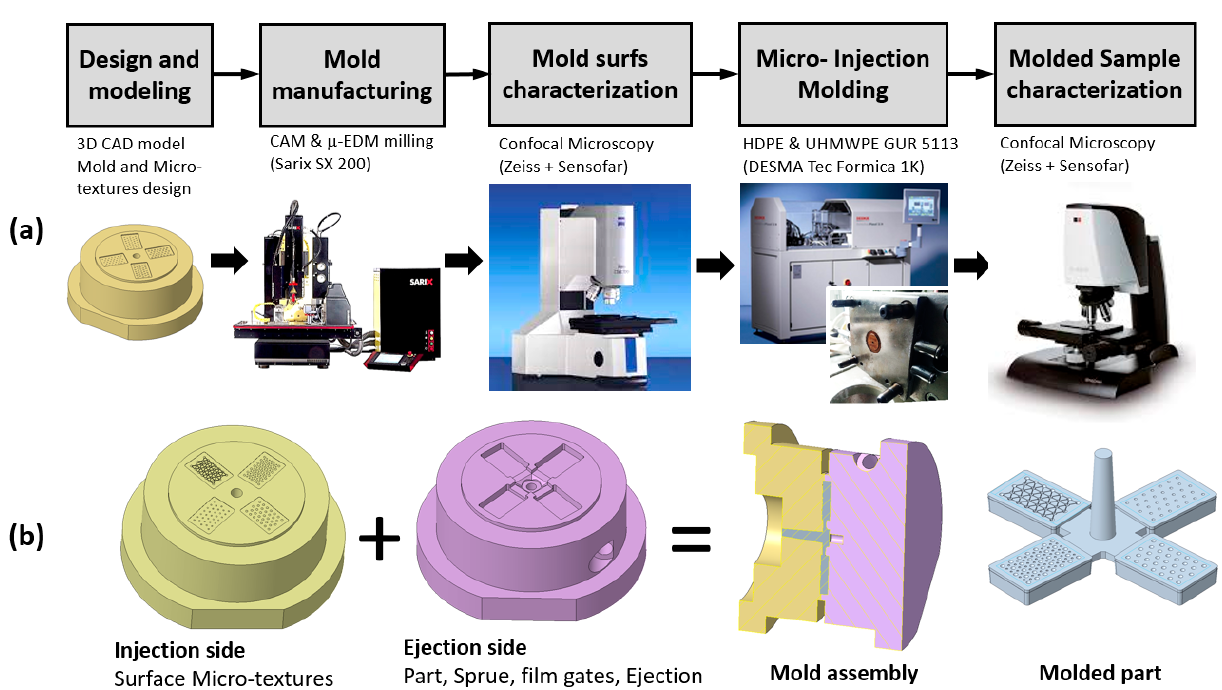
Figure 6. Micro-manufacturing process chain ( a ); mold components and molded samples ( b ).